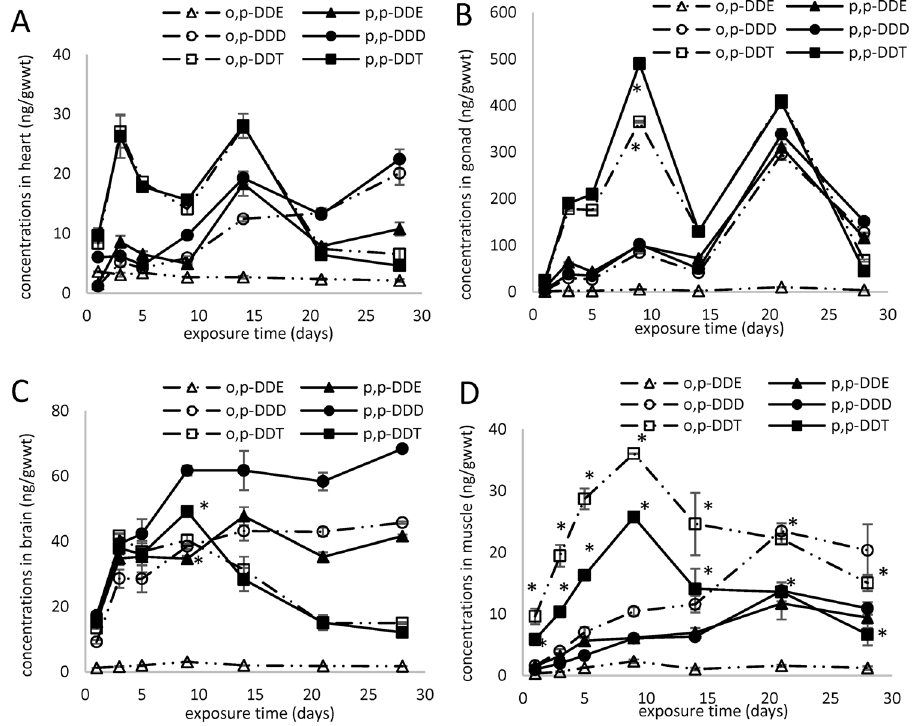
Figure 3. The accumulation of DDTs in heart ( A ), gonad ( B ), brain ( C ) and muscle ( D ) in carp in the treatment group. * Indicates significant difference between p,p’-DDT and o,p’-DDT ( p < 0.05, S-N-K